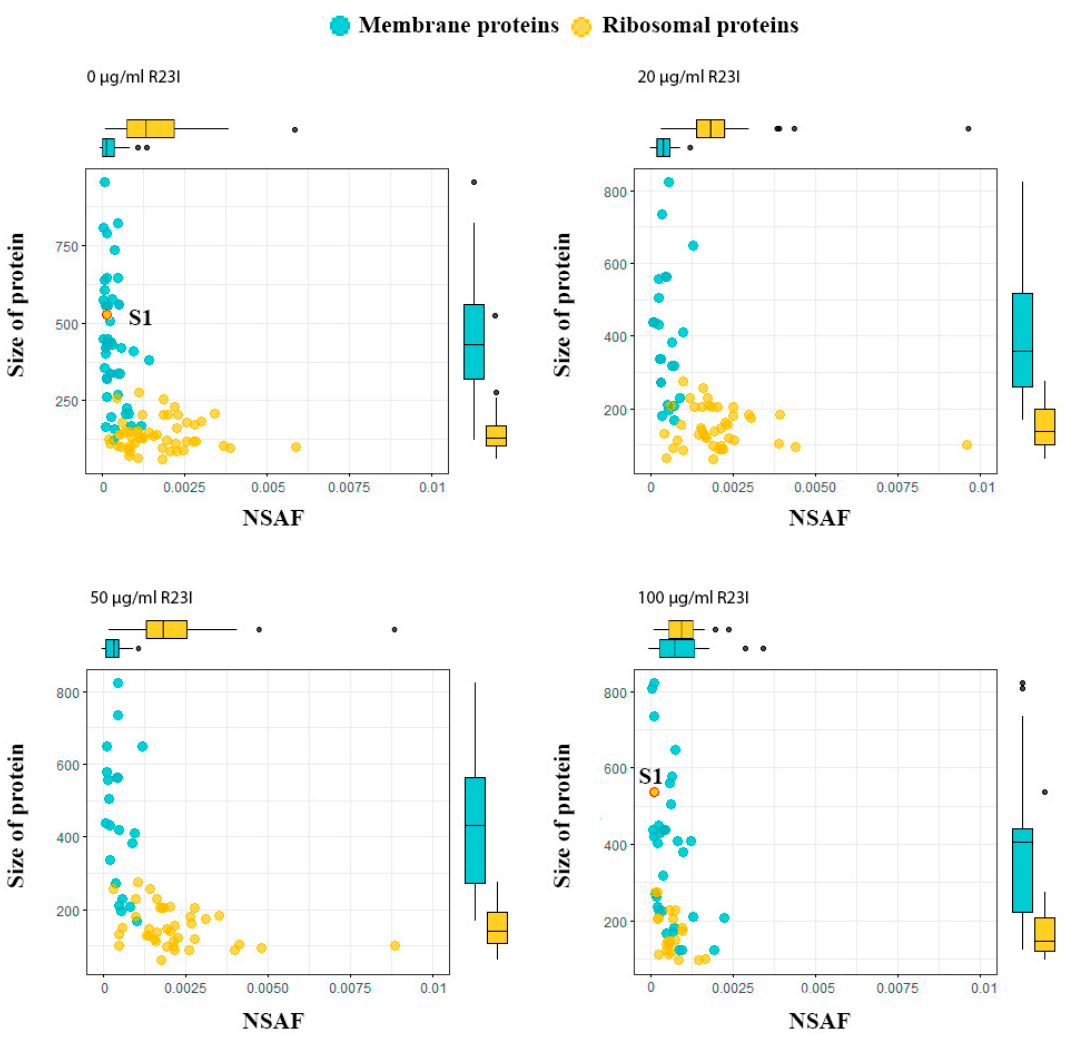
Figure 9. Proteins of T. thermophilus cells in the di ff erent experimental groups. Boxplots above and on the right describe the distribution of points along the axes. Most of the points lie within the boxplots, outliers are marked with points.